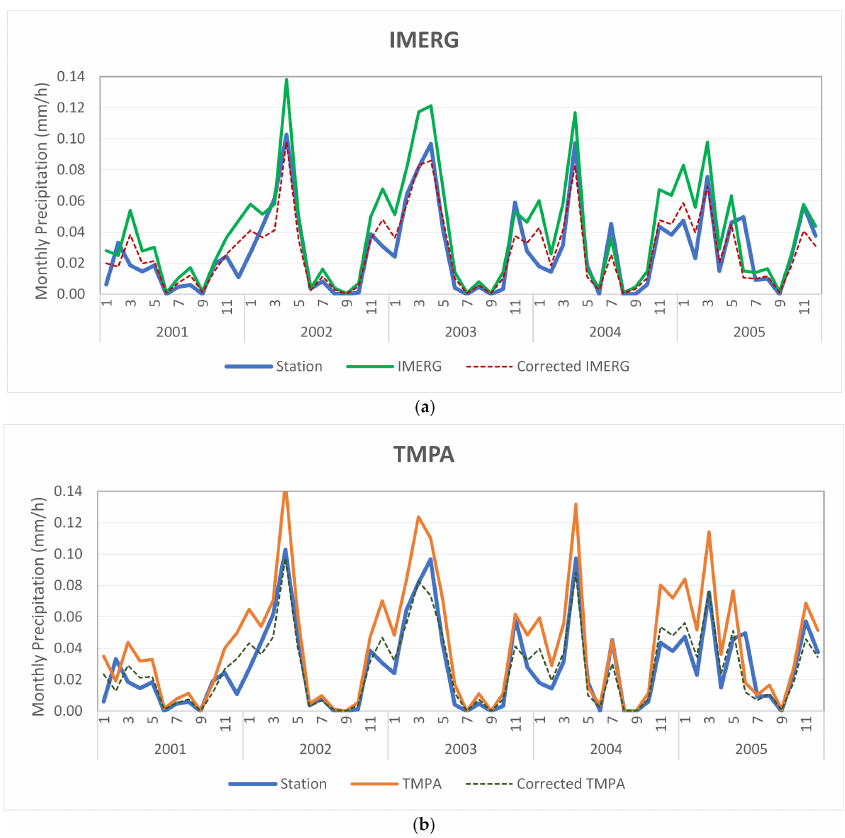
Figure 5. Comparison of monthly precipitation change graphs of ground-station measurement, IMERGV6, TMPAV7, and corrected data (using CF) from 2001 to 2005 for Bojnoord in semi-arid and low rainfall conditions. ( a ) IMERG, ( b )